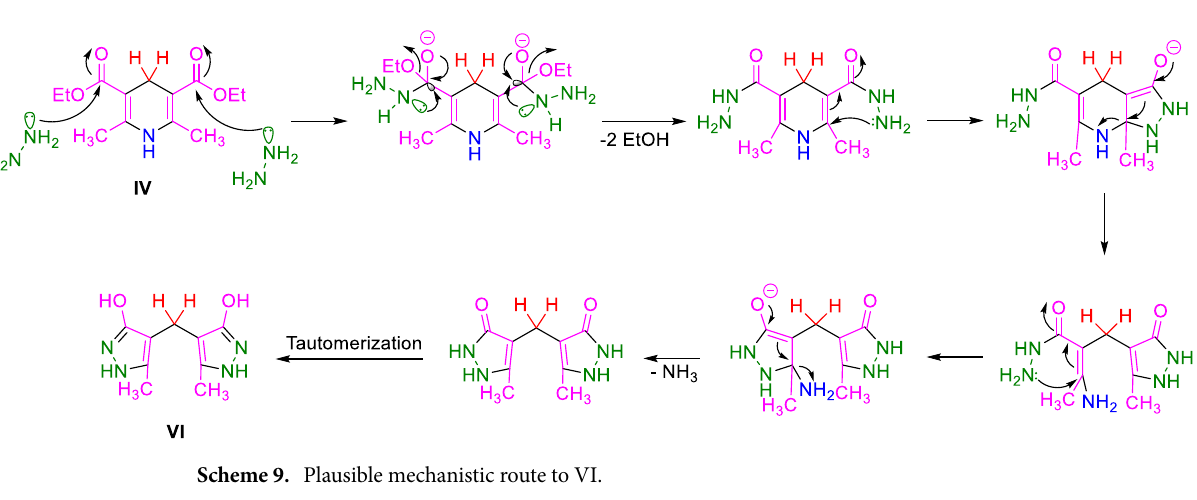
Scheme 9. Plausible mechanistic route to